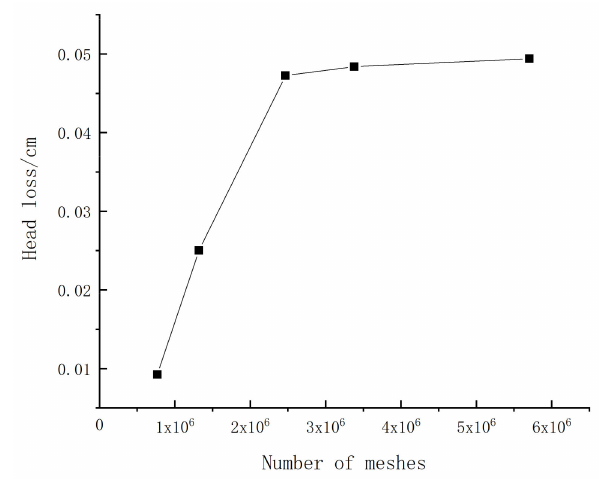
Figure 5. Head loss with different mesh quantities.